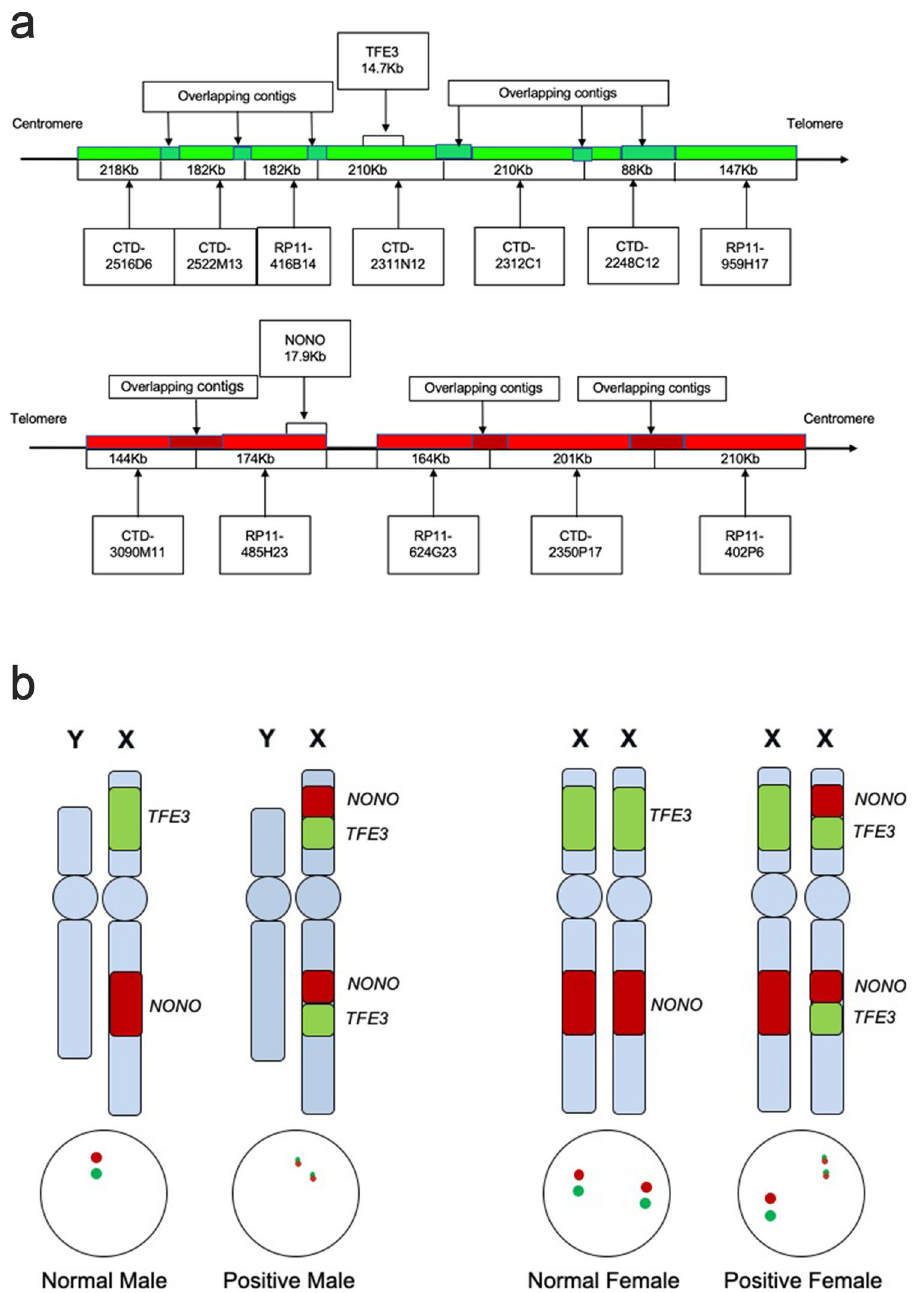
Figure 1. A schematic representation of the NONO-TFE3 dual-fusion probe. ( a ) Bacterial artificial chromosomes (BACs) labeled with red fluorescence covered the almost entire NONO gene, and BACs